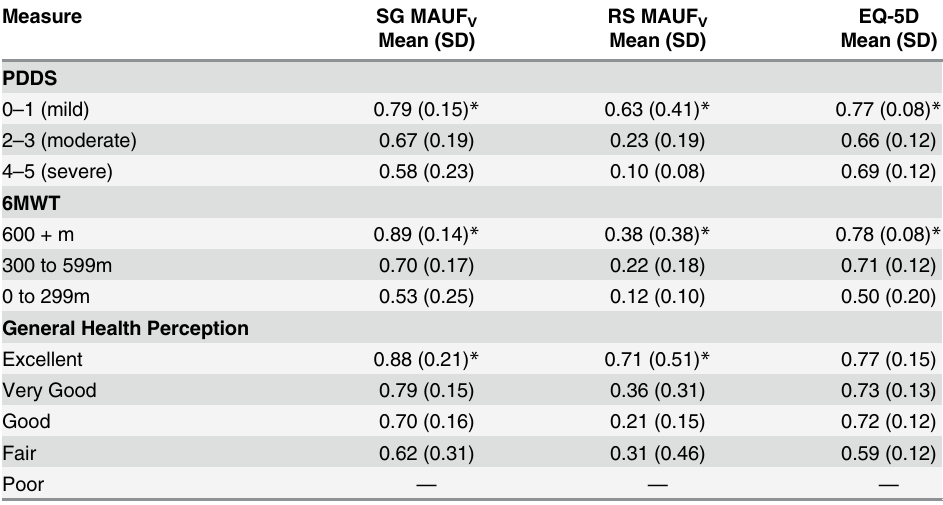
Table 8. Known-groups validity of the PBMSI and the EQ-5D index against external measures of dis- ease severity in the validation sample. Measure